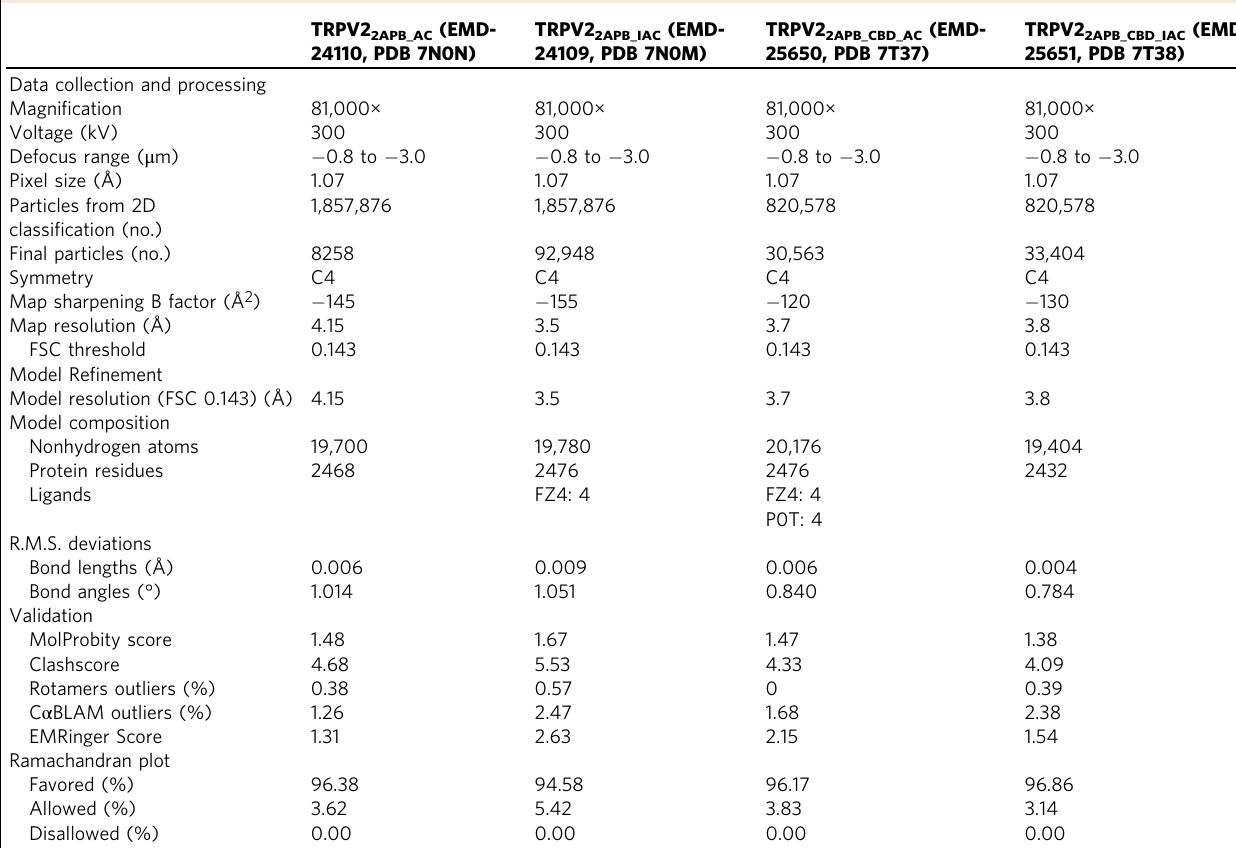
Table 1 Cryo-EM data collection and model